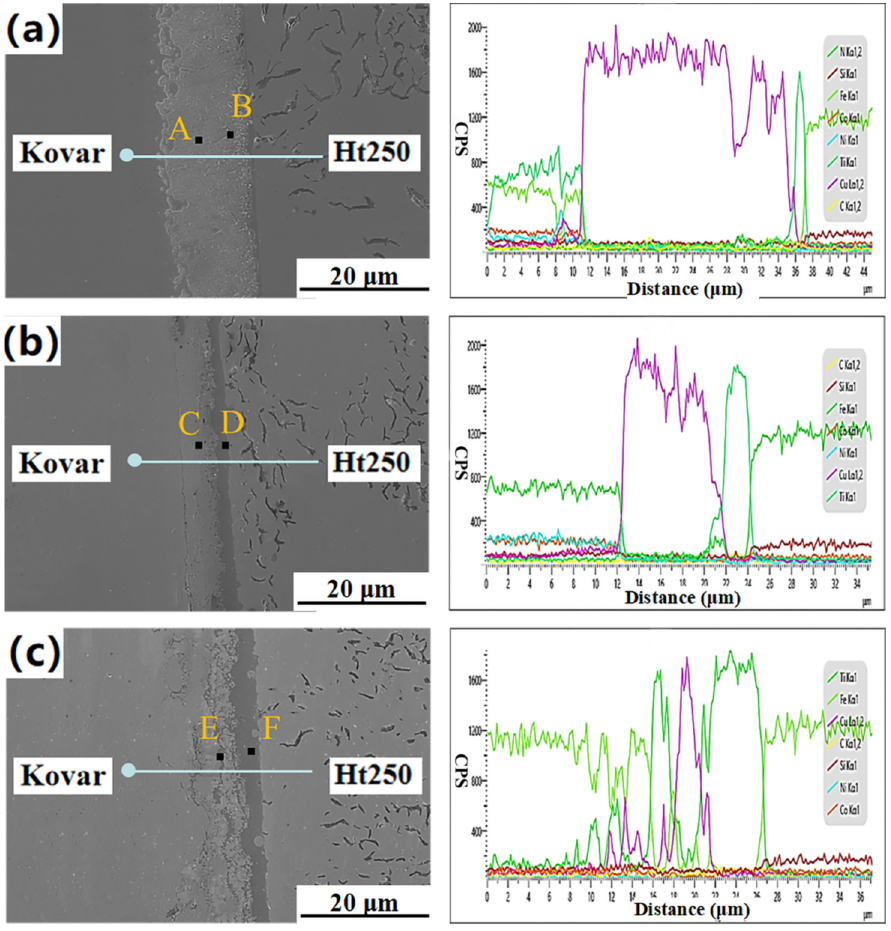
Figure 11. Microstructure and line scan analysis of Kovar/Cu/Ti/Ht250 joint under different holding times: 1 h ( a ), 2 h ( b ), or 3 h ( c ).